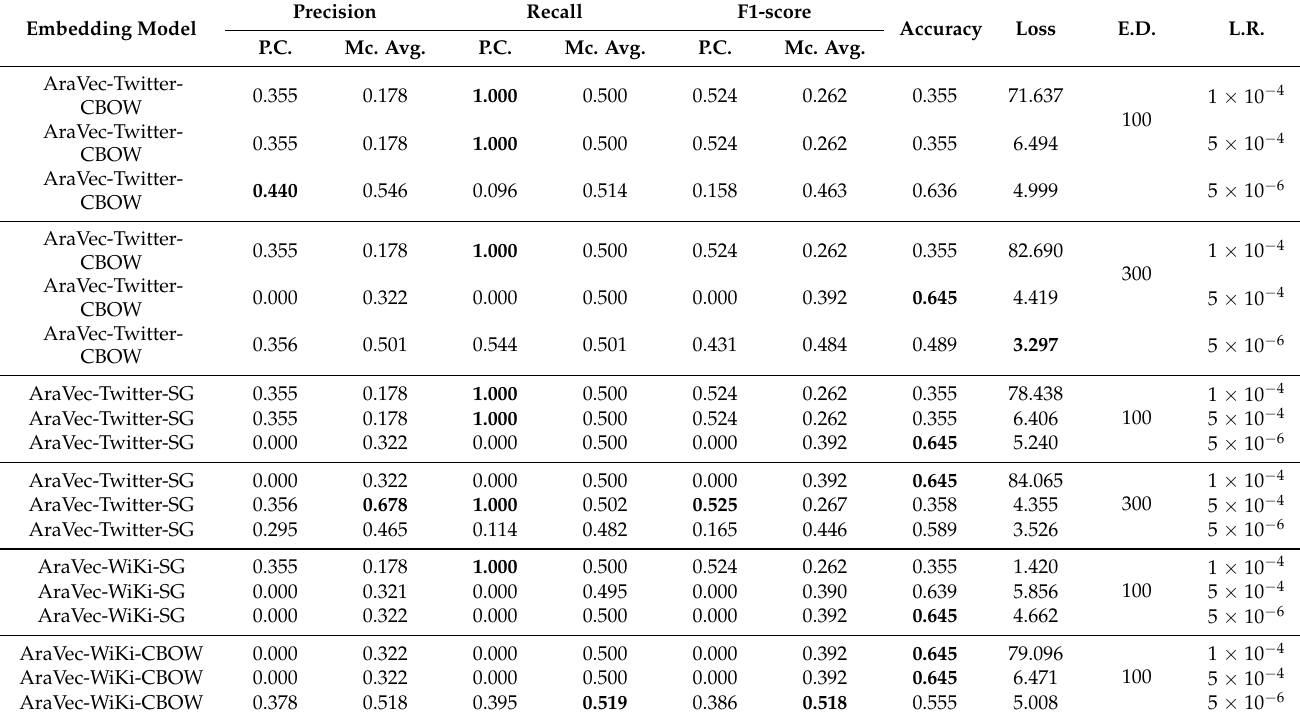
Table 3. The results of adopting the transcripts only by using the Conv1D-DNN model at different embedding models and dimensions, and at different learning rates, regarding the precision, recall, and F1-score of the positive class and the macro-average of the classes (E.D. is the embedding